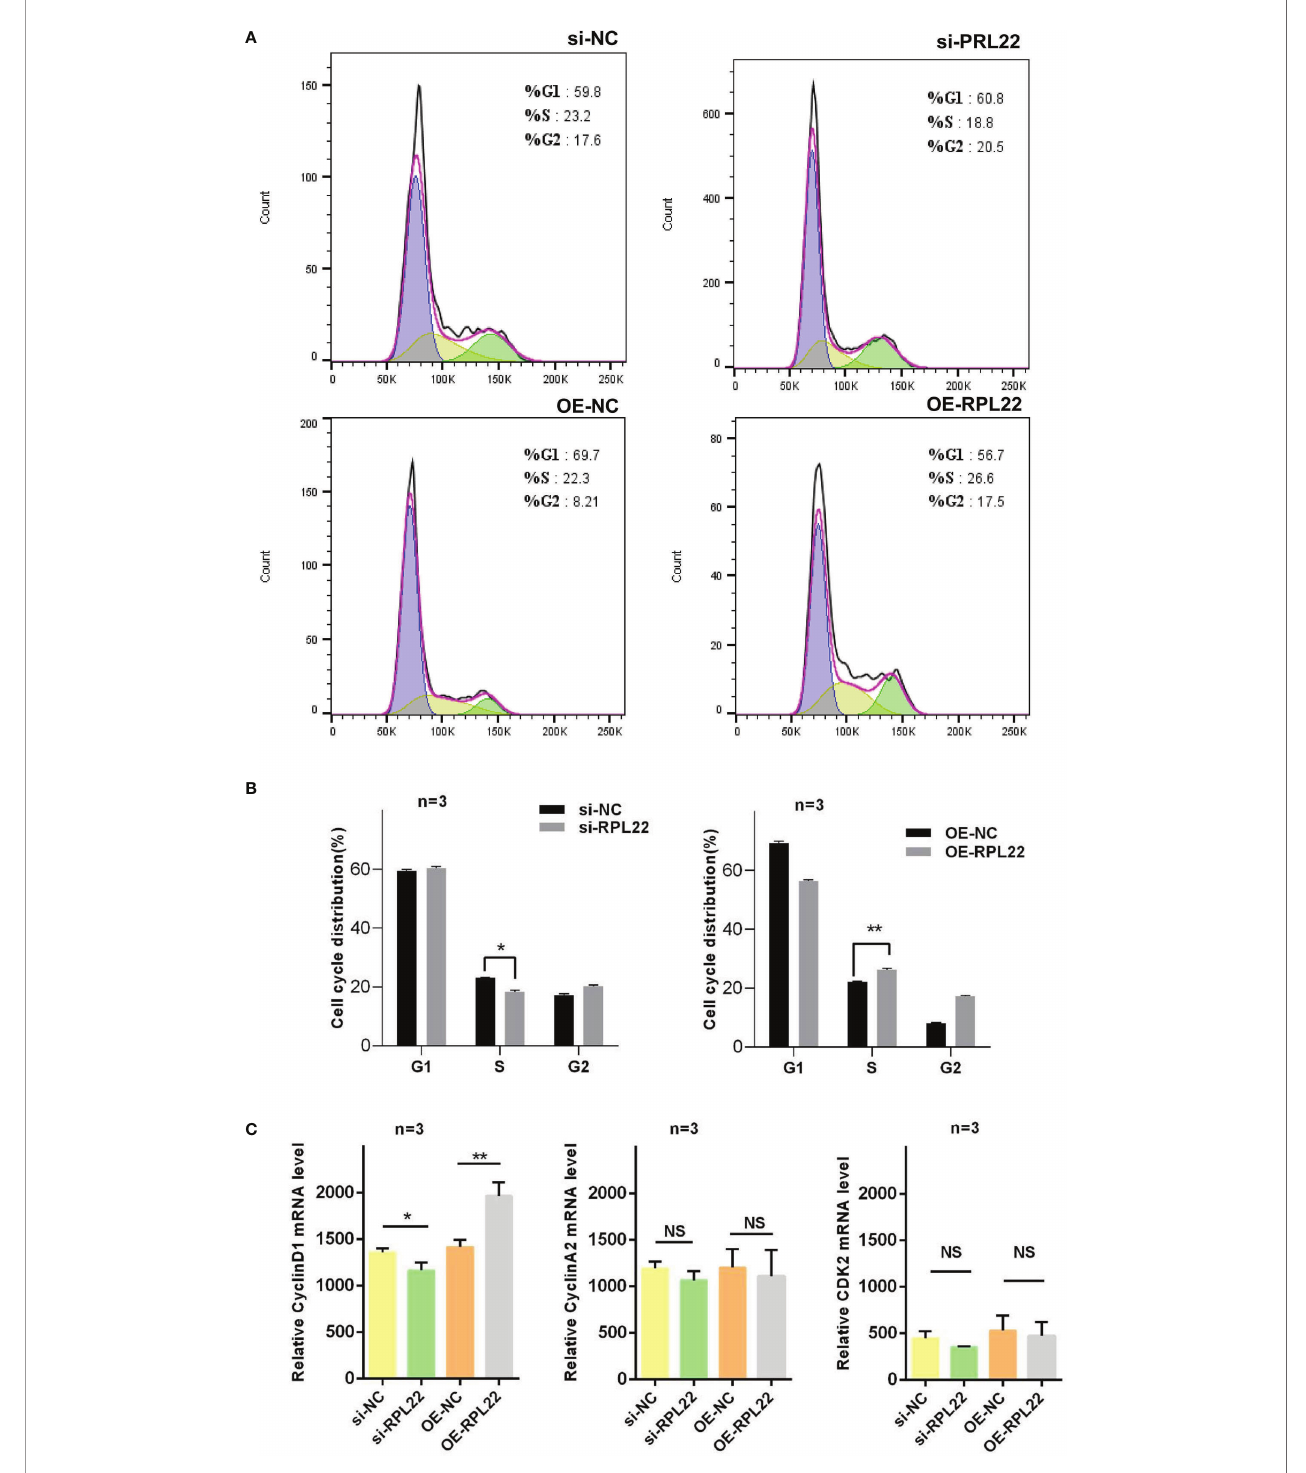
FIGURE 4 | RPL22 is involved in the cell cycle. (A) Flow cytometry to detect the cell cycle of HaCaT cells transfected with si-RPL22 or OE-RPL22 and their controls (n = 3). (B) Statistical analysis data to show the difference of four groups at 48 hours. (C) The mRNA levels of cell cycle-related protein including CyclinD1, CyclinA2 and CDK2 in HaCaT cells transfected with si-RPL22 or OE-RPL22 and their controls (n = 3). All data are representative of at least 3 independent experiments. Data represent the mean ± SEM. *P < 0.05, **P < 0.01. NS, not signi fi cant. Two-tailed unpaired Student ’ s t test was